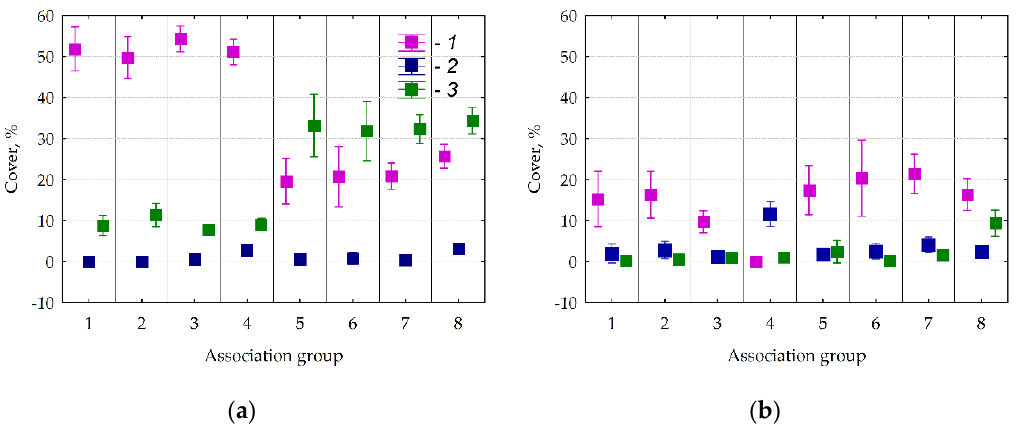
Figure 6. Cover and composition of tree layer in 8 association groups: ( a ) A1 and ( b ) A2; 1—spruce, 2—broad-leaved species (oak and lime) and 3—aspen/birch. Box-whisker type: mean/std.err. 2—broad-leaved species (oak and lime) and 3—aspen / birch. Box-whisker type: mean /